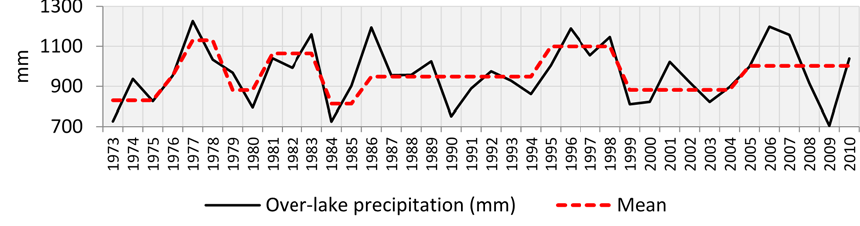
Figure 5. Regime shift of over-lake rainfall.